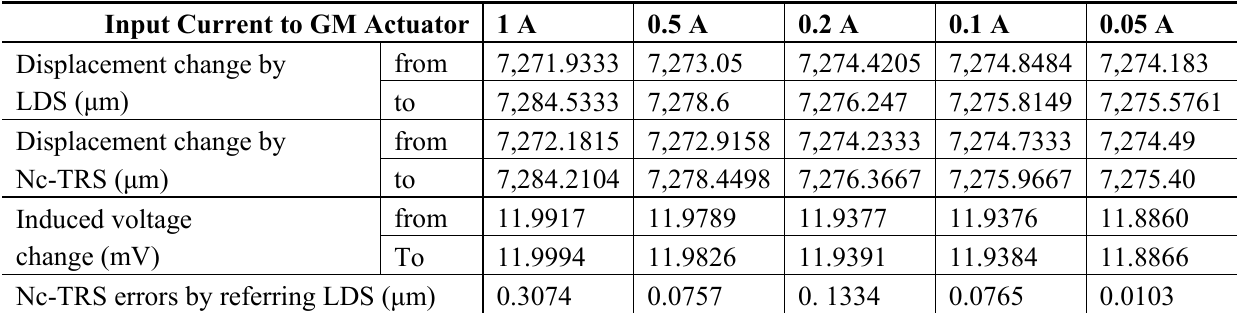
Table 1. The analyzed results of the fine displacement measurement.